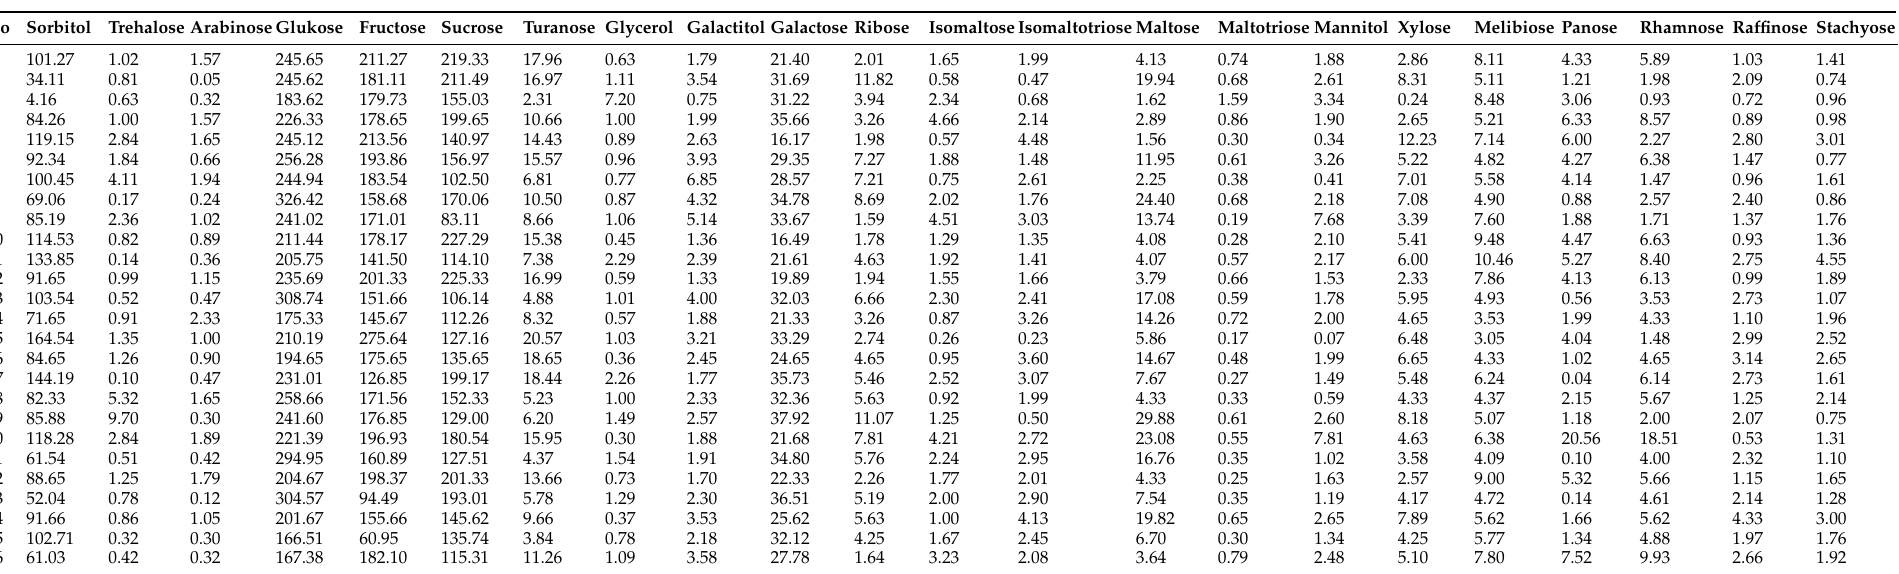
Table A2. Content of sugar compounds (g/kg dw) in 68 Norwegian plum cultivars from Njøs (42 samples) and NIBIO Ullensvang (8 samples) collected in 2019 and 2021 and from NMBU (18 samples) collected in 2019 and